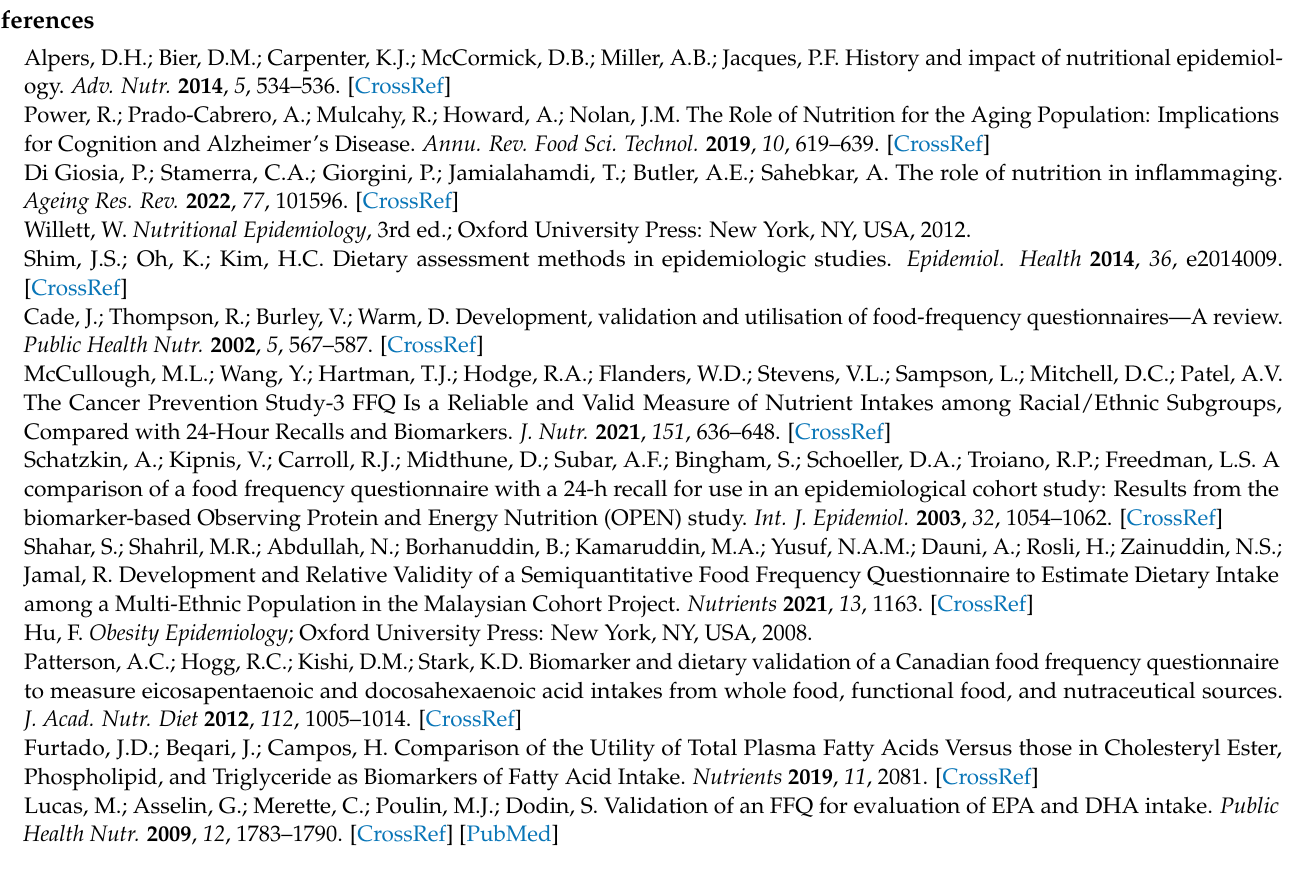
the 24-HDRs; Figure S3: Spearman correlation coefficients of food group intakes estimated by the SFFQ and the 24-HDRs in the International Human Phenome Project (phase I); Figure S4: Spearman China Cohort; Figure S5: Spearman correlation coefficients of nutrient intakes estimated by the SFFQ and the 24-HDRs in the International Human Phenome Project (phase I); Figure S6: